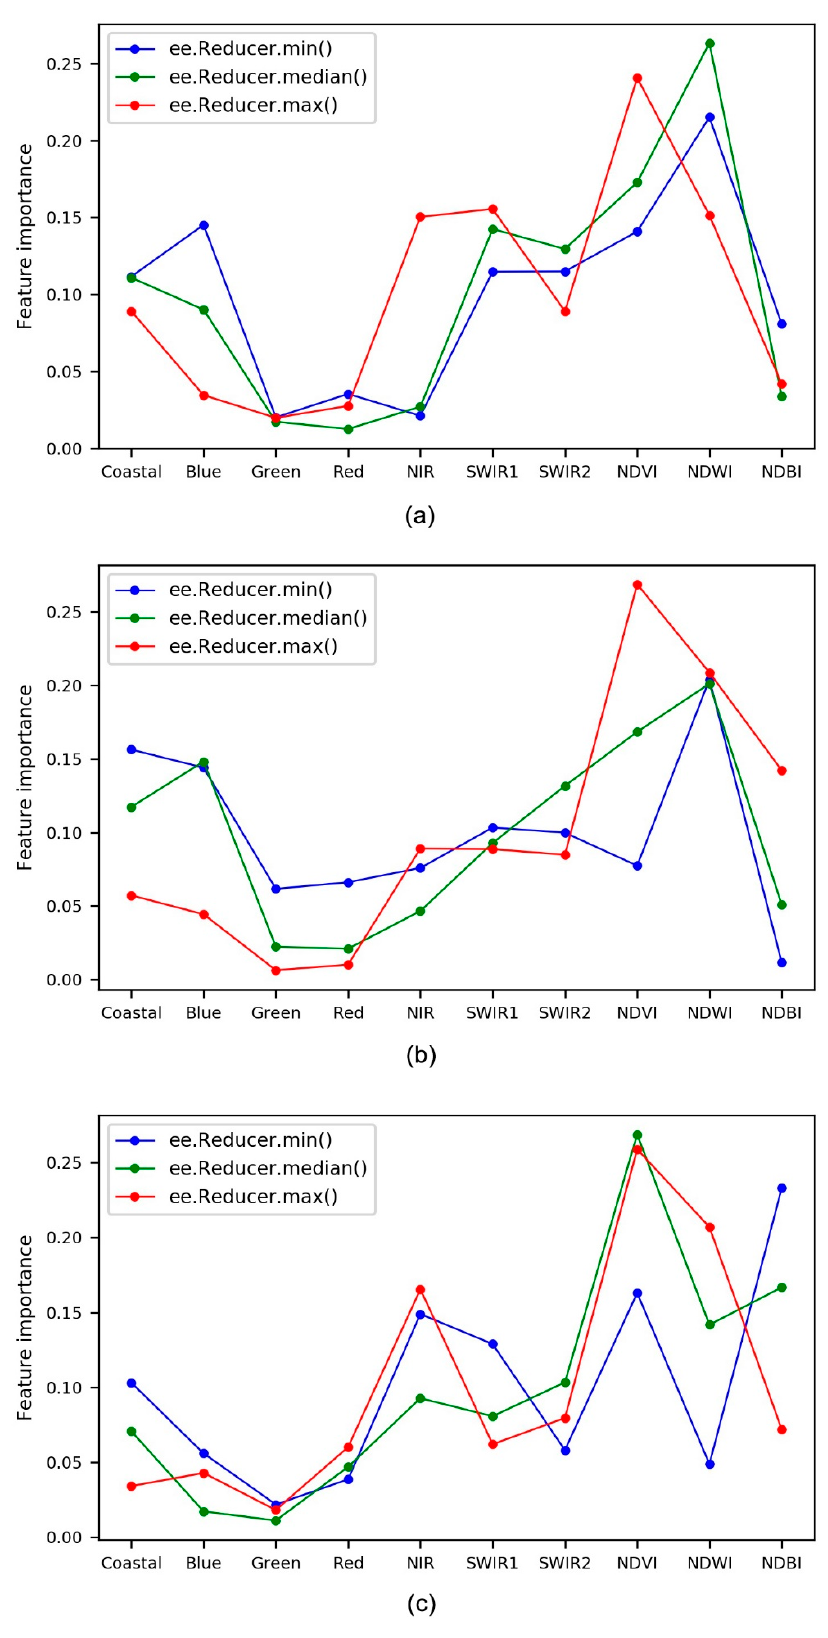
Figure 9. Feature importance by random forest in the three study areas (( a ), ( b ), and ( c ) represent Beijing, Xi’an, and Xiamen, respectively).